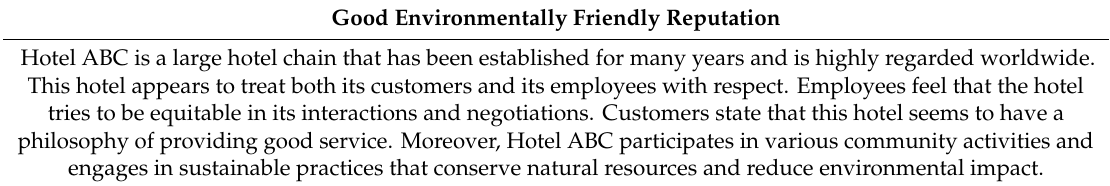
Table 1. Example of environmentally friendly reputation